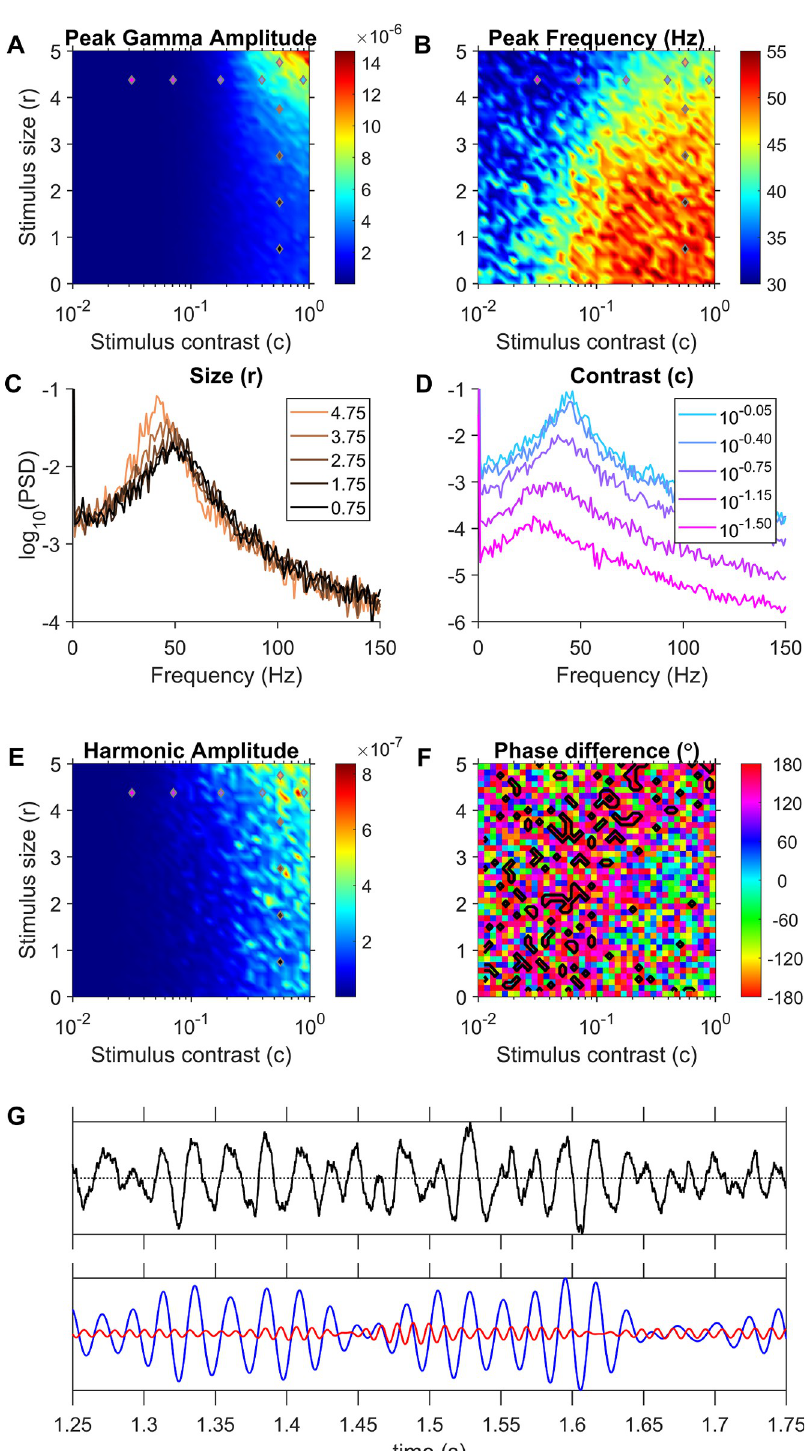
Fig 6. Gamma properties for the JXK model. (A) Gamma peak amplitude and (B) frequency found in the average PSD from 50 iterations at each stimulus size (r) and contrast (c) combination. (C) Average PSD of LFP proxy traces generated at fixed contrast and different sizes, across all iterations. (D) Average PSD of LFP proxy traces generated at different contrasts at a fixed size. The stimuli values that generated these PSDs are indicated in plots (A), (B) and (E) using colored markers (same colors as the plots in C and D). Input combinations used in (C) were chosen to